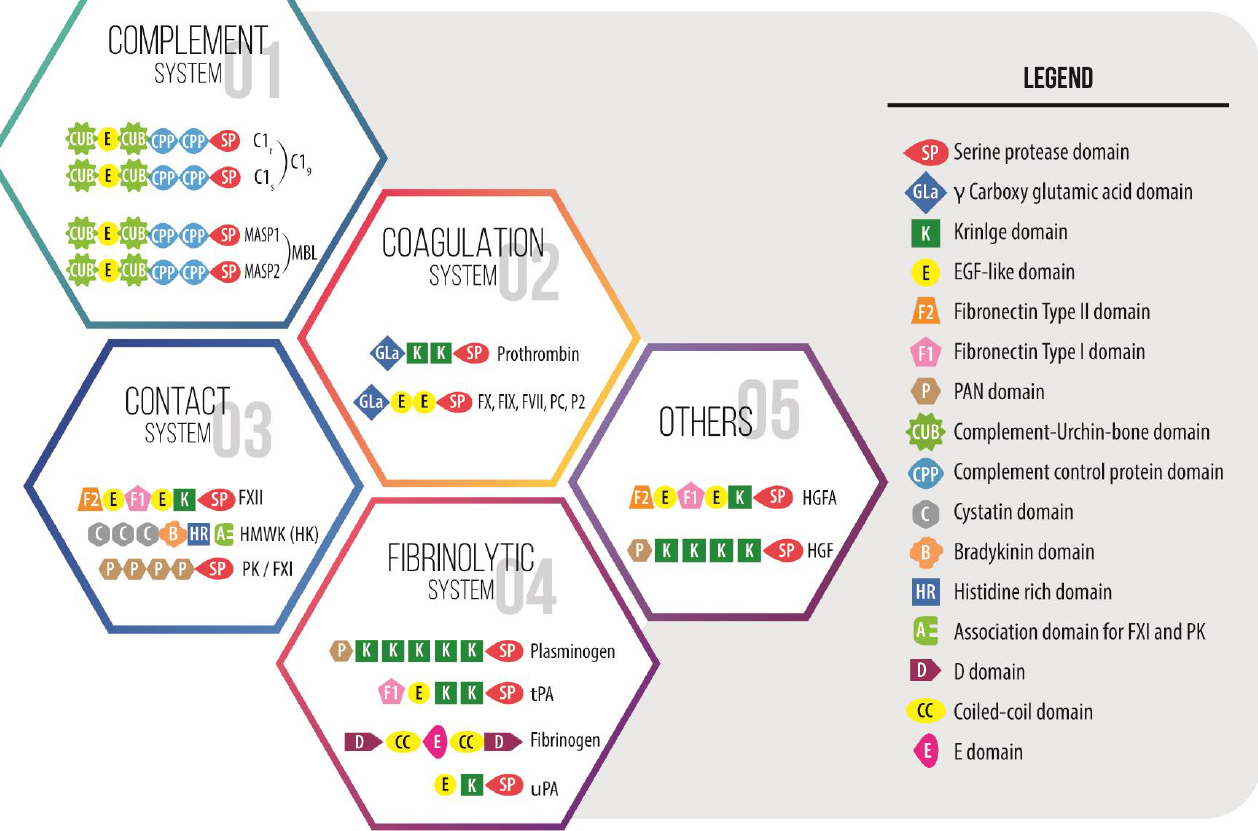
Figure 2. Domain organization of some multidomain proteins that make up the intravascular innate immune cascade systems with the catalytic serine protease domain as a key enzymatic region. These proteins share some domains with intrinsic chemical affinities useful in generating cooperative networks as pathogen and damage pattern recognition molecules, among other functions. Moreover, many of the proteins involved in coagulation and fibrinolysis are unique in that a large number of functions may coexist in one molecule and domain, which communicate signals across very different pathways. In these multifunctional molecules, the noncatalytic regions are involved in morphogen signaling, cell–cell and cell–matrix adhesion and interaction, thereby playing roles in other processes from embryonic development to inflammation to healing and beyond. The numbers in the figure are for illustrative purposes and do not correspond to the order of appearance from an evolutionary point of view.